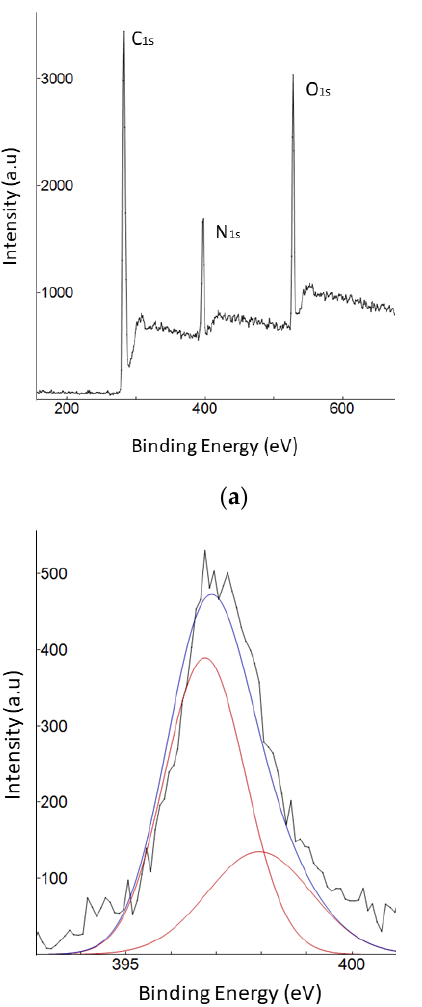
wavelength. In the fluorescence spectra (Figure 6b), the optimum excitation and emission lengths for CQDs are 358 and 440 nm, respectively. wavelengths for CQDs are 358 and 440 nm,